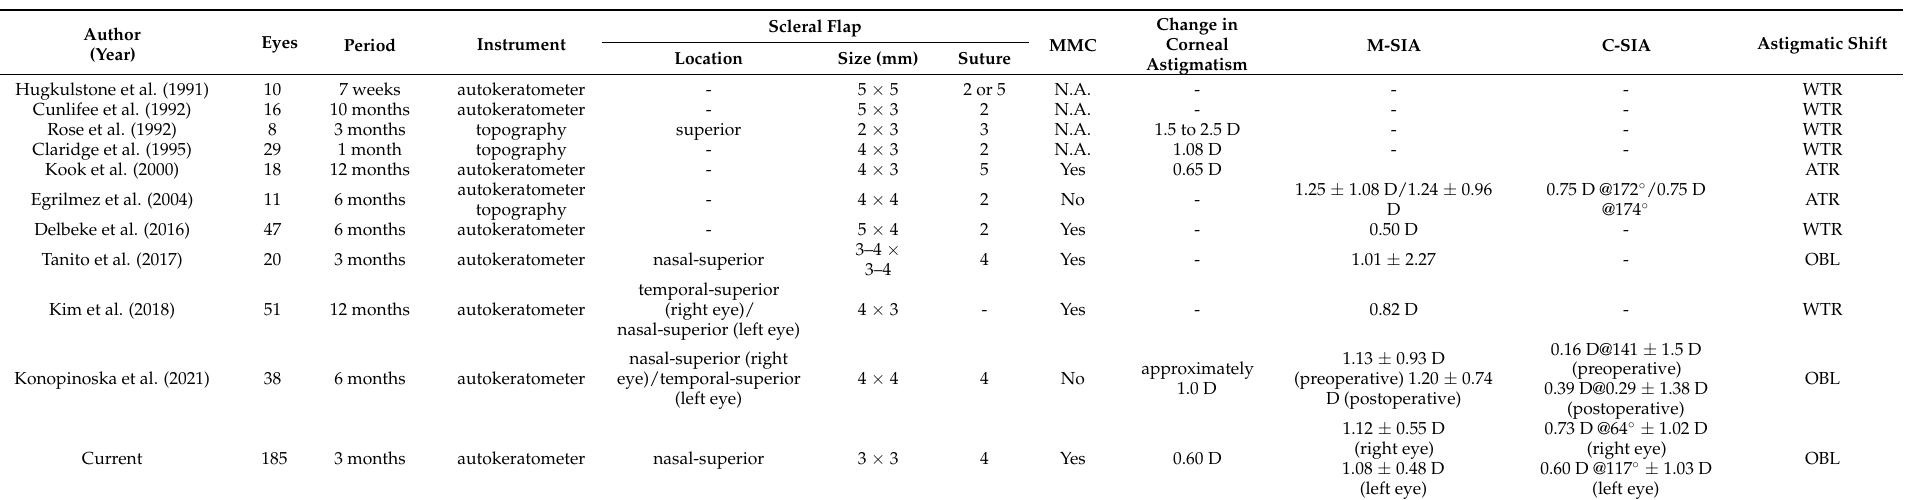
Table 2. Previous studies on surgically induced astigmatism in eyes undergoing